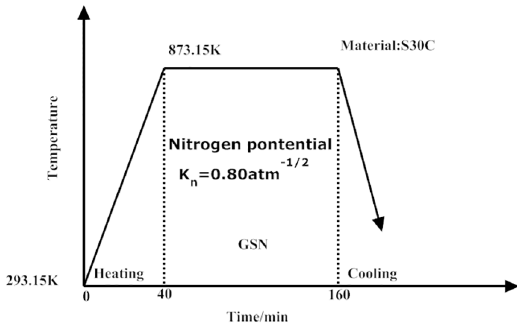
Figure 1. Heating programme of nitrding process.